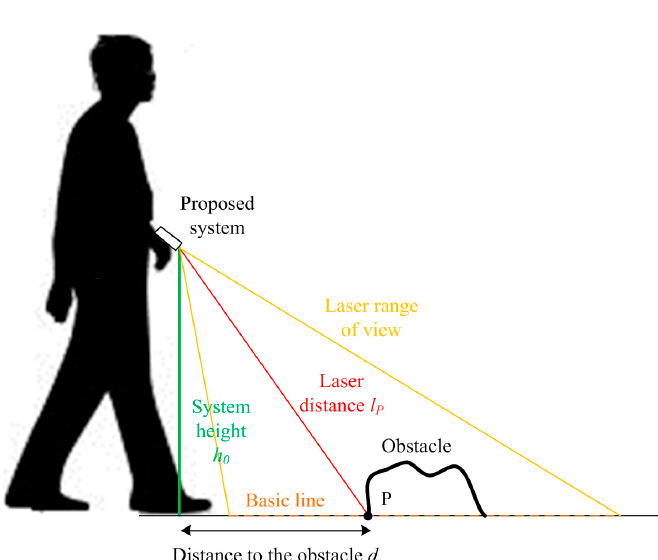
Figure 8. Distance estimation for the obstacle.